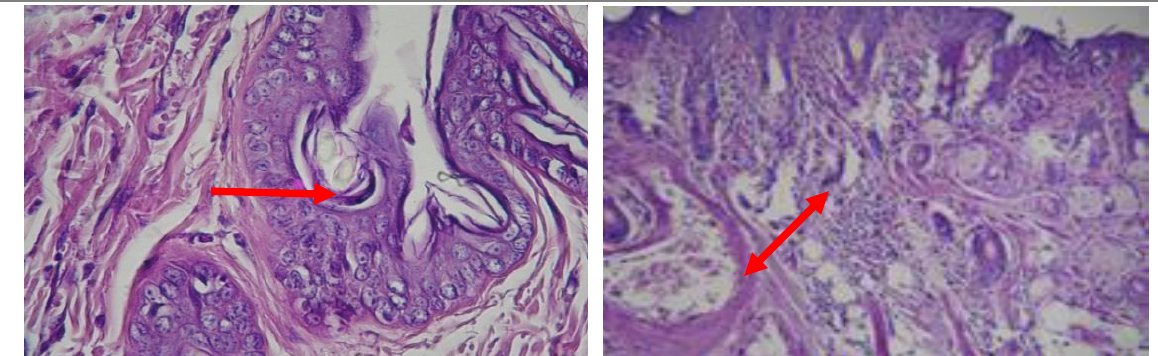
Figure, 17: Section in skin of immunized animal at 60 day post challenge show reveals intense proliferation of MNCs in dermal and hypodermal tissue with proliferation of hair follicle and sebaceous gland as well as dilation and congestion of blood vessels (H&E Stain 400X). References